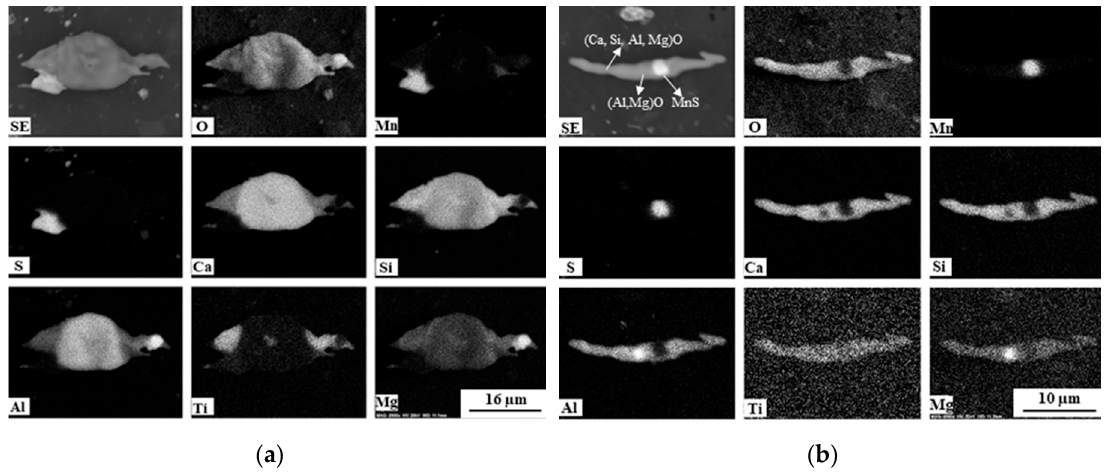
Figure 4. Element mapping of Type III ( a ) and Type IV ( b ) inclusions in Ca-treated steel.